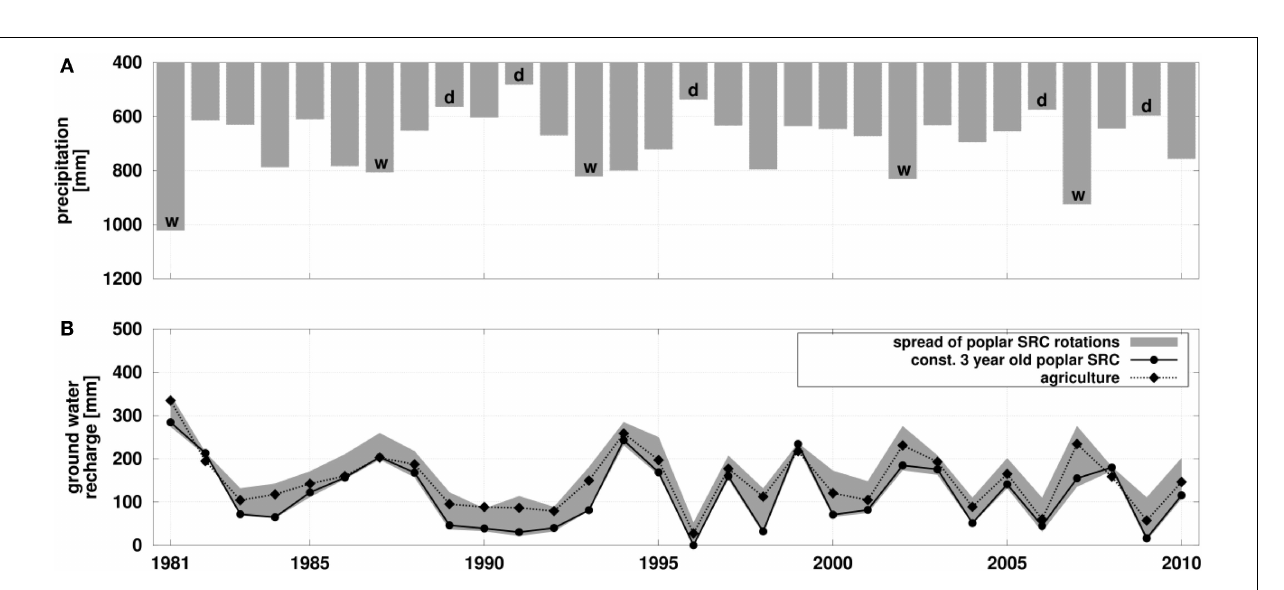
FIGURE 4 | Comparison of plot model results for the two land use types agriculture and poplar SRC – with and without rotation . (A) Sums of precipitation for hydrological years (Oct–Nov), “d” marks the 5 driest years and “w” the 5 wettest years in the period 1981–2010; (B) sums